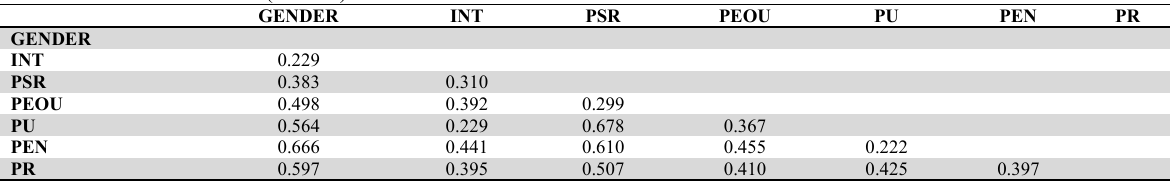
Heterotrait-Monotrait Ratio